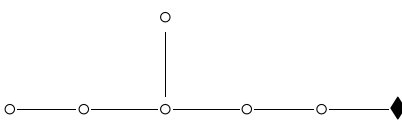
and % = 56 . 7( (cid:0) 25) , and hence the E 7( (cid:0) 25)